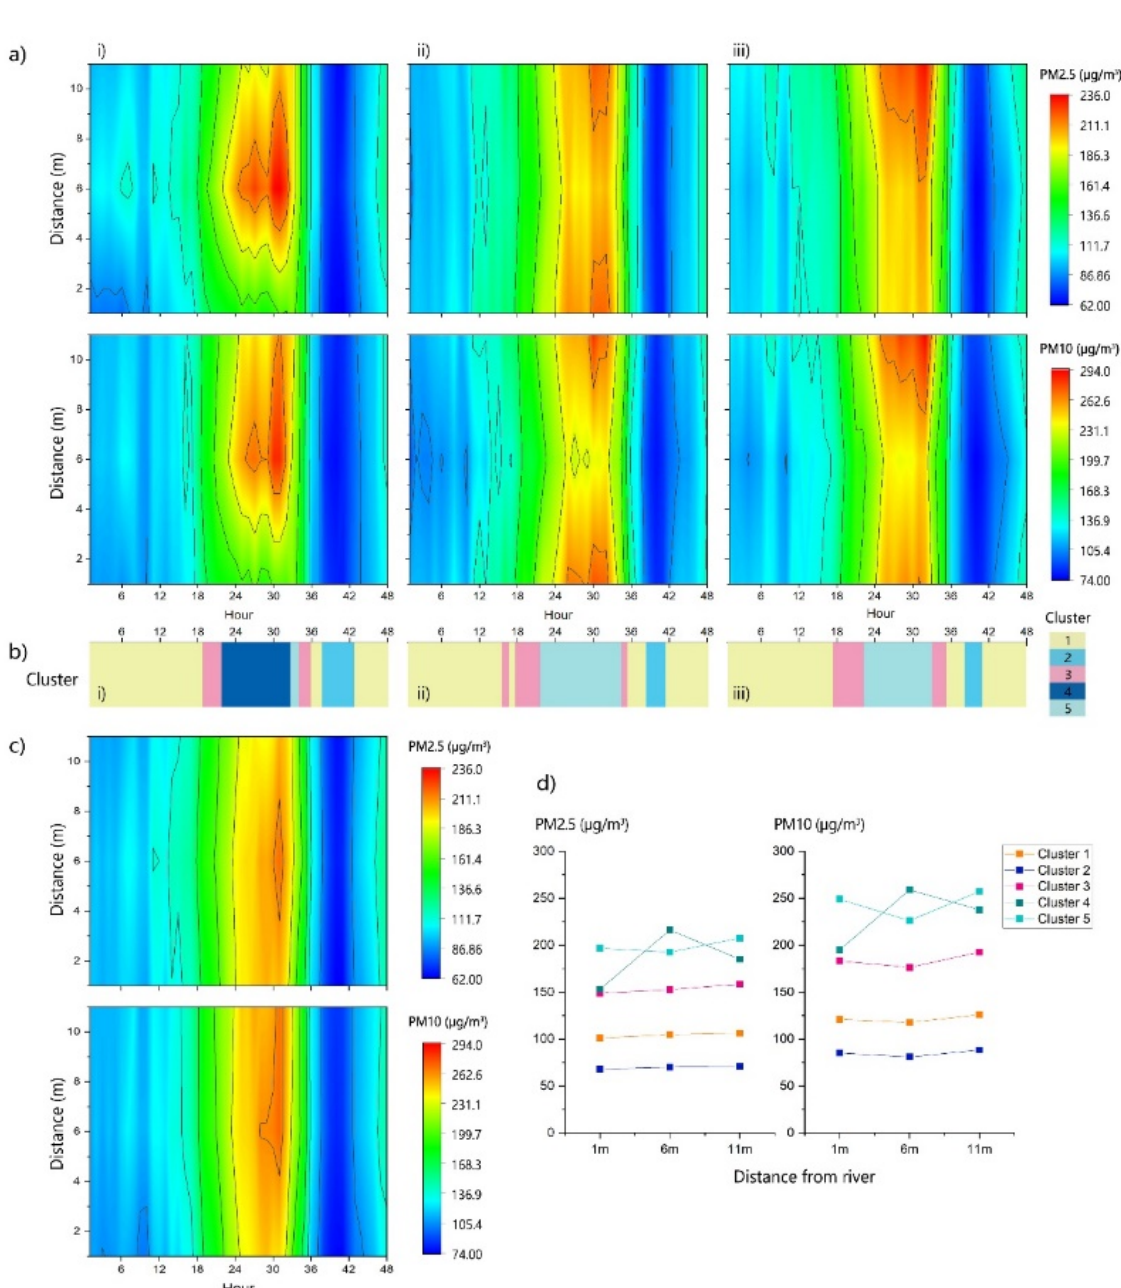
Figure 3. Results of the cluster analysis of the PM 2.5 and PM 10 spatial distributions across time. ( a ) Spatial-temporal distribution of the PM 2.5 and PM 10 concentrations in (i) grassland (G); (ii) arbor-grass (AG) woodland; (iii) arbor-shrub-grass (ASG) woodland generated using hourly data points at the distances of 1 m, 6 m, and 11 m from the river. ( b ) The distribution across time of five clusters in (i) grassland (G); (ii) arbor-grass (AG) woodland; (iii) arbor-shrub-grass (ASG) woodland as a result of the hierarchical cluster analysis. ( c ) The spatial-temporal distribution of PM 2.5 and PM 10 in the background atmosphere at 10 m above ground. ( d ) The average PM 2.5 and PM 10 concentrations at the stepped distance of five clusters based on the hierarchical cluster analysis.